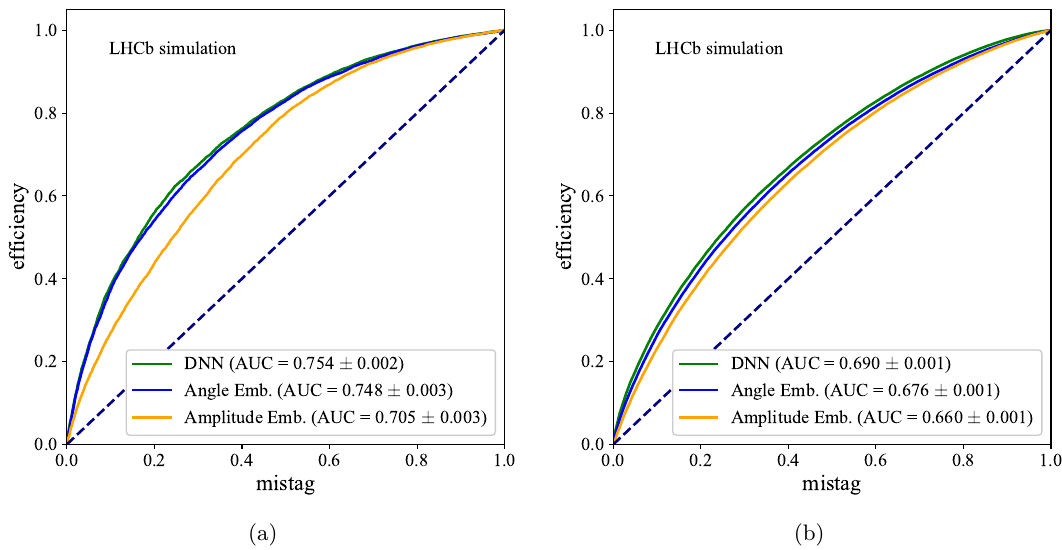
Figure 5. ROC distributions and AUC score for DNN (green), Angle Embedding (blue) and Amplitude Embedding circuits (yellow) for the muon dataset (a) and the complete dataset (b). The dashed line represents a random